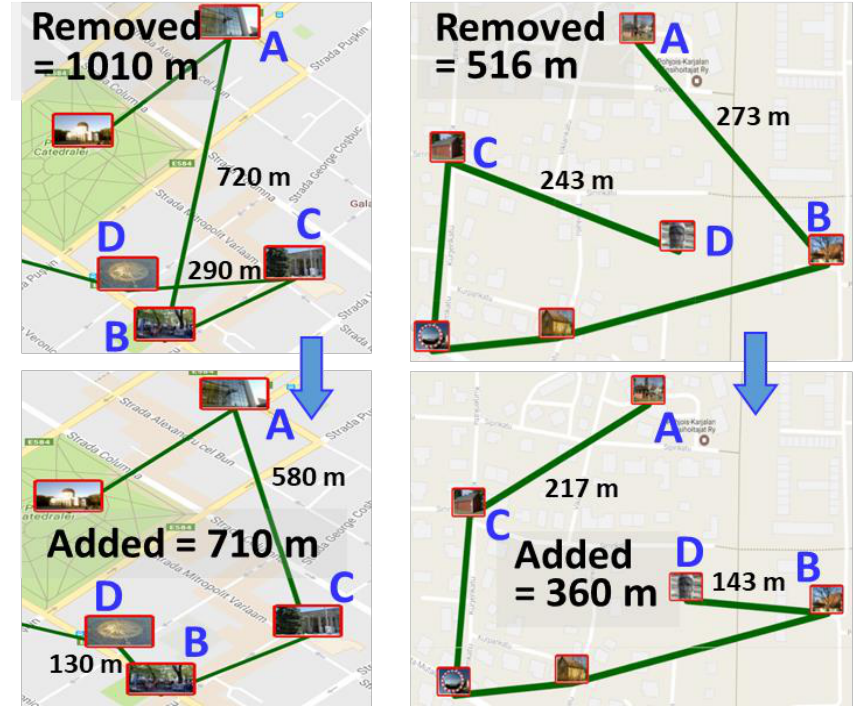
Figure 5. Two examples of the 2-opt method in O-Mopsi.